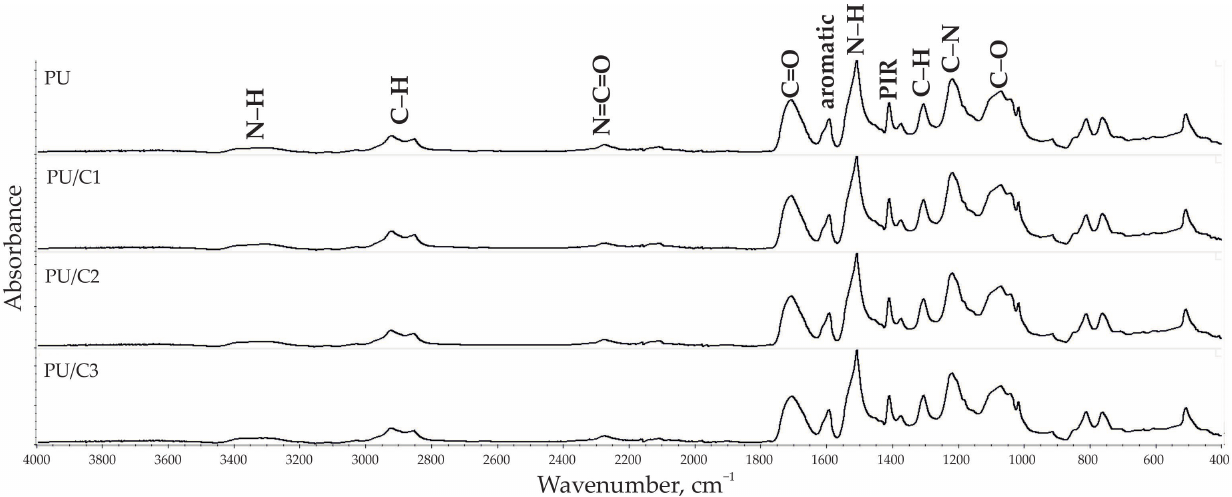
Figure 6. FTIR spectra of PUR foam and its composites with 1 php cellulose (PU/C1), 2 php cellulose (PU/C2), and 3 php cellulose (PU/C3).